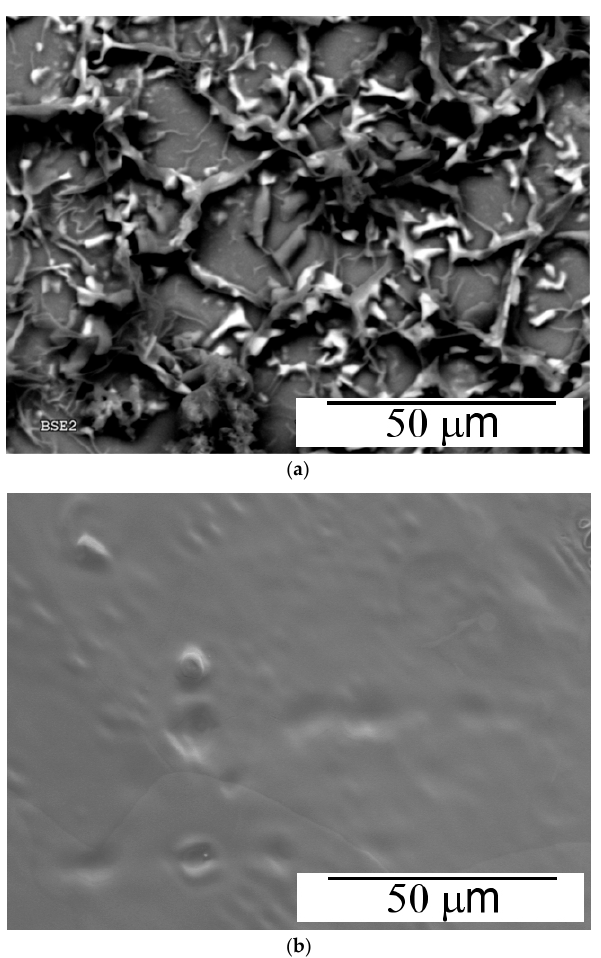
Figure 7. Scanning electron micrographs at 1000× magnification of copolymer ( a ) and polyaniline ( b ) deposited under the same experimental conditions. ( b ) deposited under the same experimental